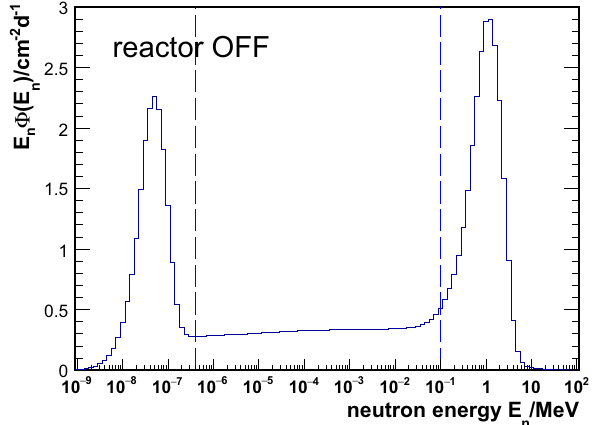
Fig. 14 Solution of the neutron energy distribution Φ ( 2 ) ( E n ) resulting from the analysis of the DS-2 data normalized to the measurement time